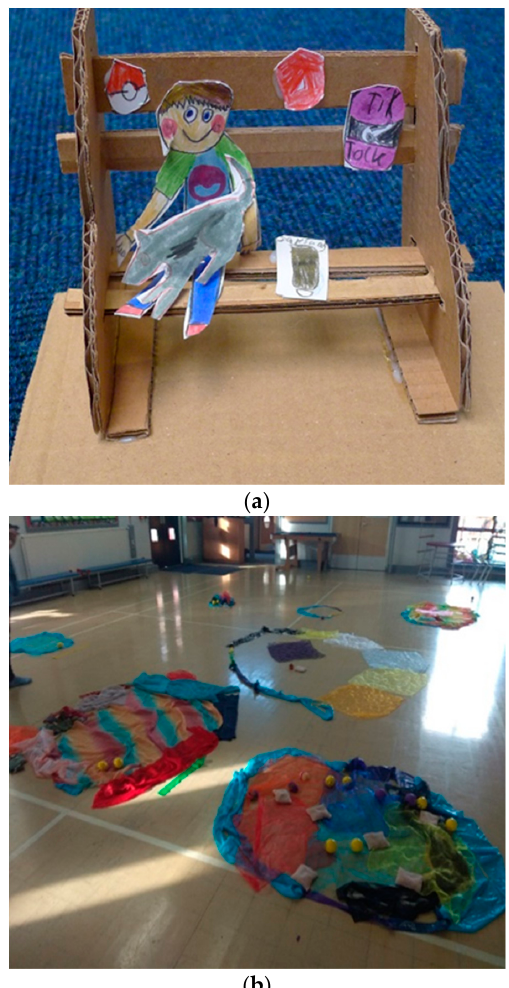
Figure 3. A safe space. ( a ) “Safe bench”—art therapy; ( b ) “Safe home’”—dance movement therapy.